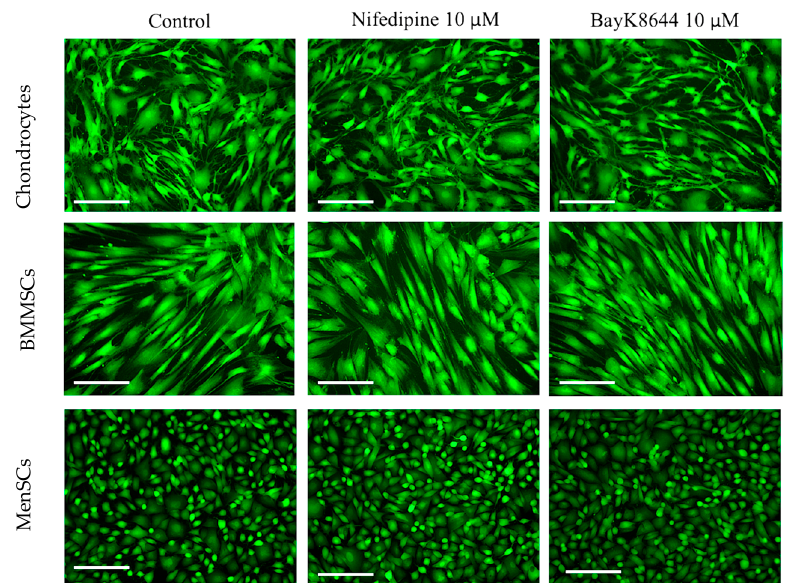
Figure 2. The iCa 2+ levels in MenSCs, BMMSCs and chondrocytes cultivated in a monolayer, a ff ected with nifedipine (10 µM) or BayK8644 (10 µM) for the 3 days and stained with Cal-520 dye. Control– cells without nifedipine or BayK8644. Cells were visualized with EVOs fl uorescent microscope; the representative micrographs are shown. Scale bar 200 µm.